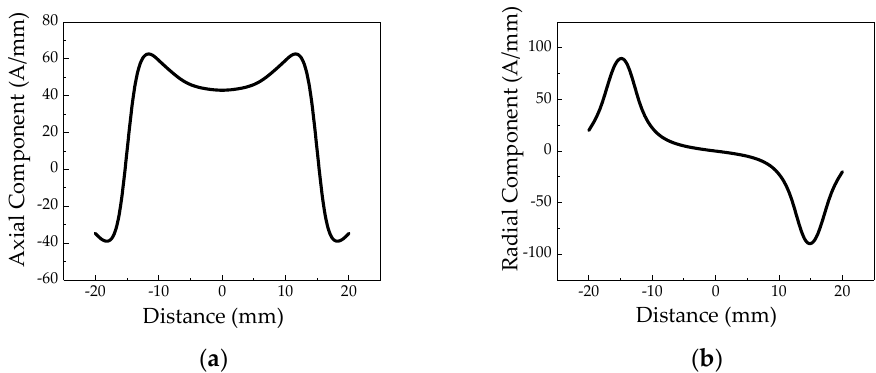
Figure 2. The characteristics of weak magnetic signal in model of non-uniform crack: ( a ) axial component and ( b ) radial component. The axial component of the weak magnetic at the crack has a maximum value near the crack tip, and a minimum value appears in the middle of the crack. The radial component of the weak magnetic at the crack has a peak and a valley at the crack tip.